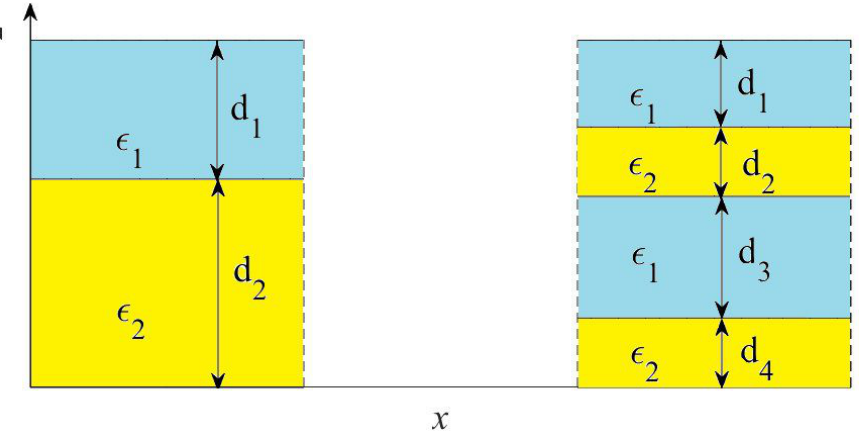
Figure 1. The sketches of the unit cell of two microgeometries under consideration: two-layer ( left panel ) and four-layer ( right panel )